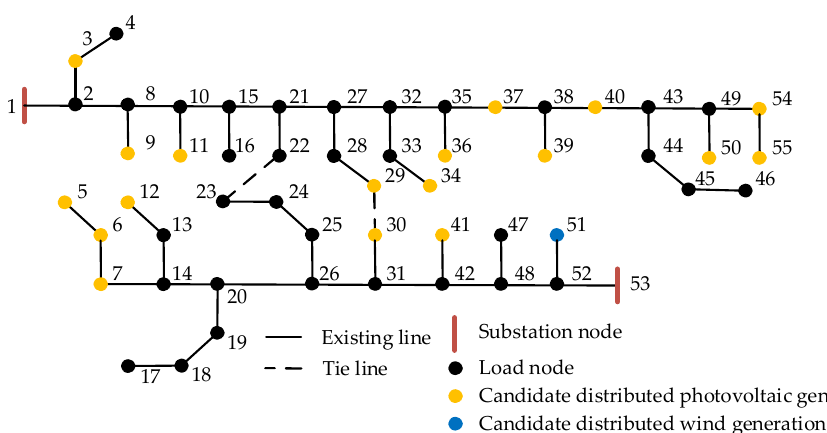
uted wind generation output and load curves of the region into consideration. Based on three distributed wind generation output curves and four distributed photovoltaic gener- ation output curves, 12 daily operation scenarios are formed. Each daily operation sce- nario includes six scheduling periods. The output curves after standardization are shown in Figure 3.